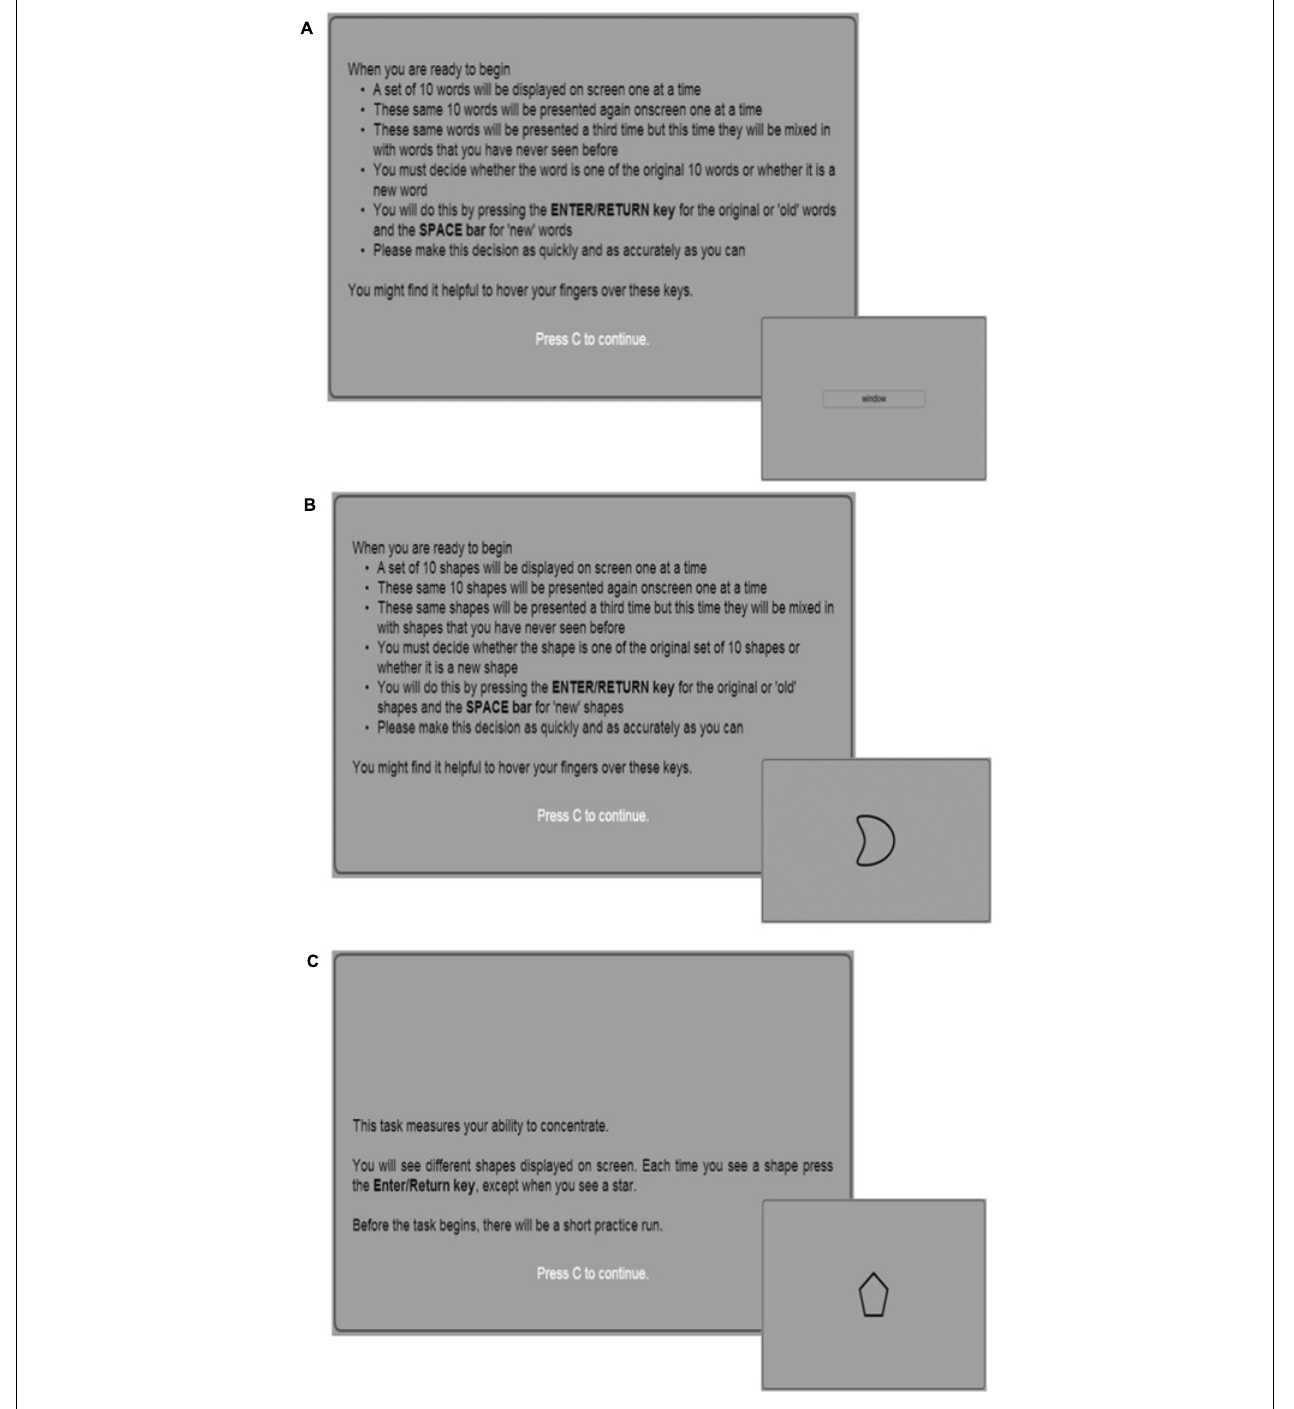
followed by a 1000 ms pause during which the screen was blank. In the recognition phase, the randomized list of 20 shapes was presented one by one until the participant response. (C) Instructions and example of non-target stimulus presented in the Shapes Sustained Attention to ResponseTask (SSART). Both types of stimuli remained on screen for 500 ms, with 1500 ms inter stimulus interval.The non-targets were presented 85 times; the target, a star, was displayed 15 times and it was presented one by one in random order with at least two non-target shapes being displayed